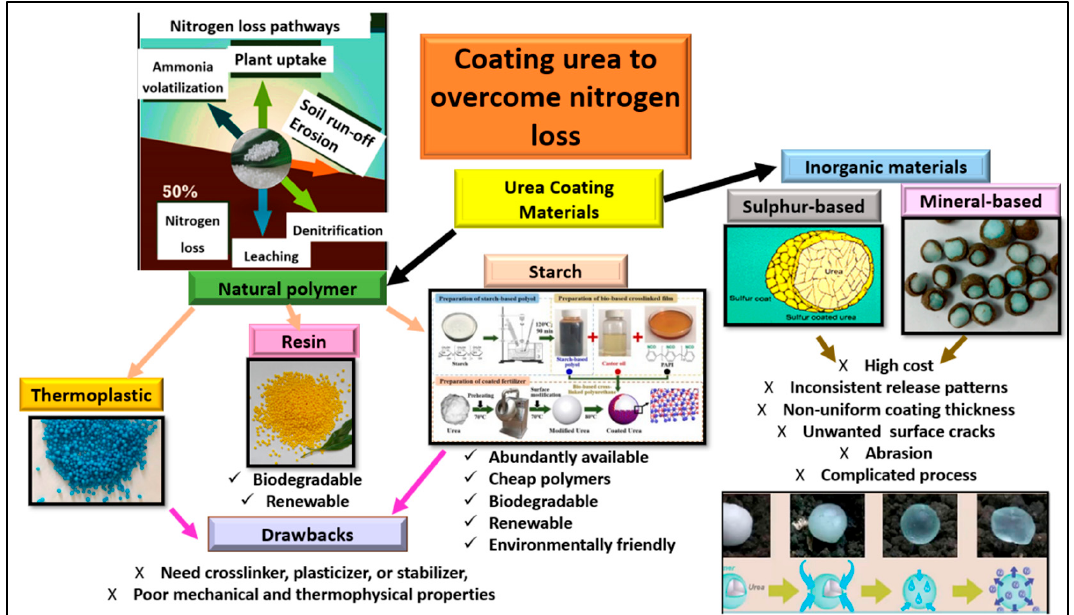
Figure 1. Common materials used for coating urea granules to prevent rapid nitrogen loss from